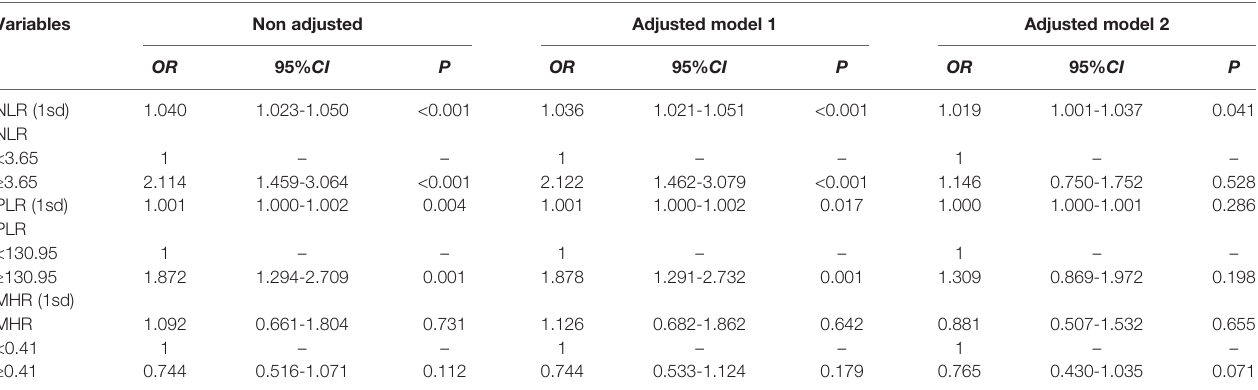
TABLE 2 | Multivariable Cox regression analysis of baseline NLR, PLR and MHR for overall survival. Variables